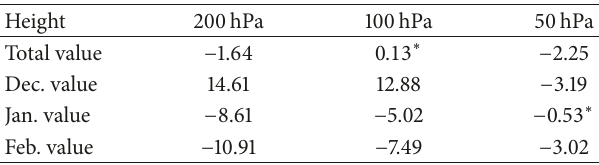
Table 2: Composite heat fluxes of SP- and SU-type El Ni˜no events during 1978–2016 (units: